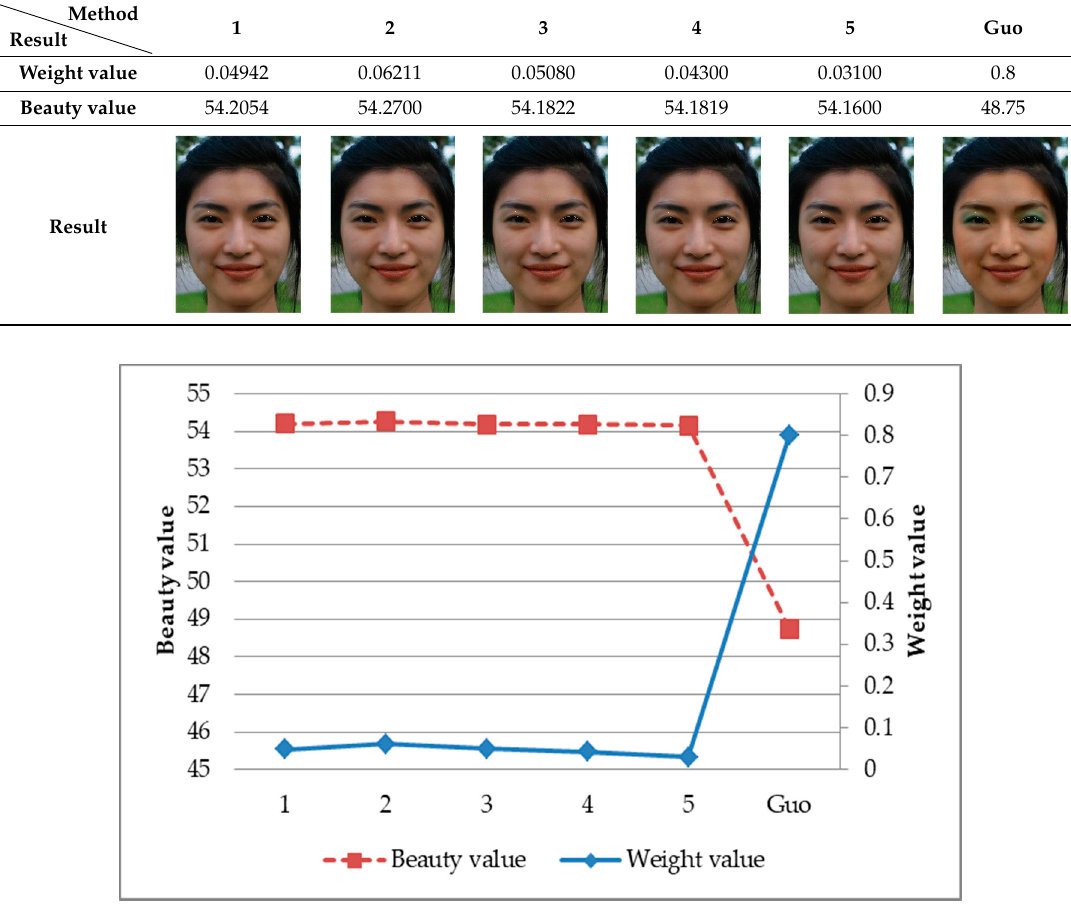
Figure 4. Comparison between Guo and ours.